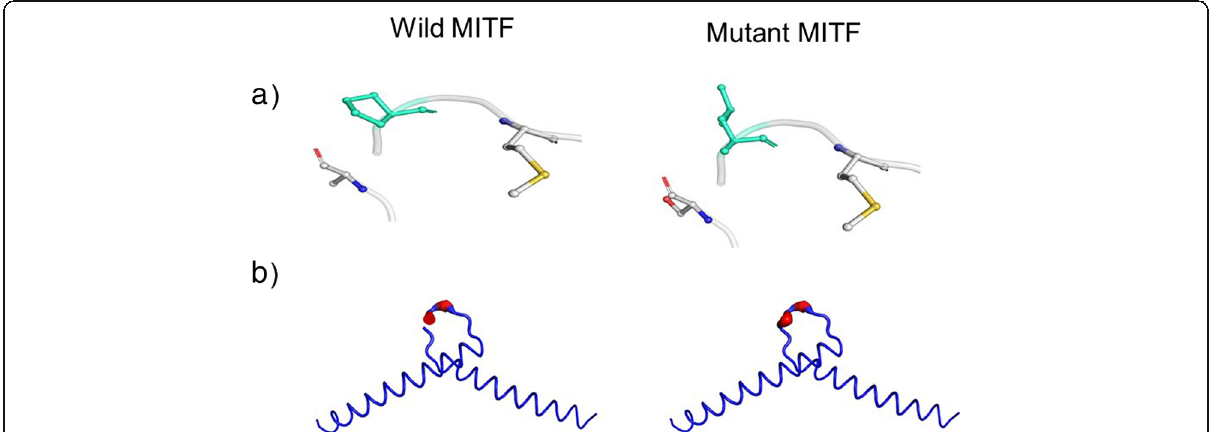
Fig. 5 Protein structure prediction of the novel MITF variant (p.P338L). In silico modeling ( a ) the effect of the MITF mutation using the DUET software shows a general destabilization of the structure ( b ). Wild-type and mutant residues are colored in light-green and are also represented as sticks alongside with the surrounding residues which are involved on any type of interactions ( a ). The magnitude of the fluctuation is represented by thin to thick tube colored blue (low), white (moderate) and red (high) ( b